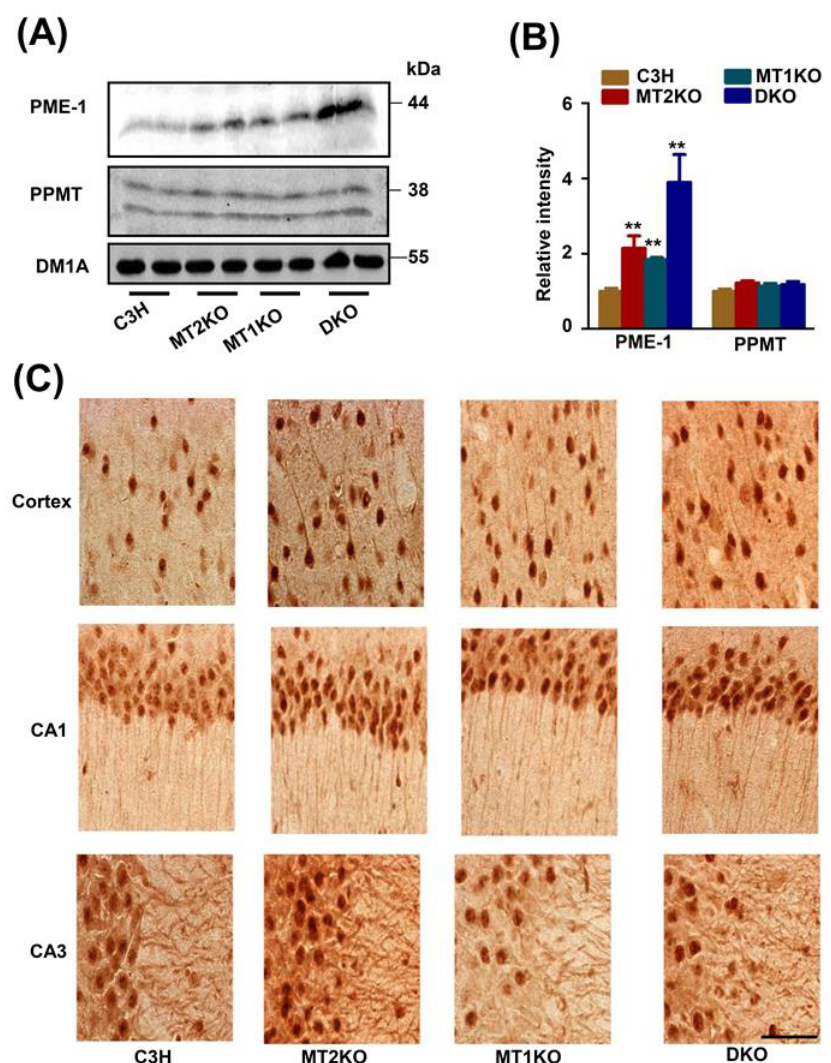
Figure 4. The expression of PME-1 in three transgenic mice. ( A ) Western blotting of PME-1 and PPMT. ( B ) Relative intensity of PME-1 and PPMT. ( C ) Immunohistochemistry for PME-1. Bar = 100μm. ** p < 0.01, compared with C3H. Data are presented as means ± SD.